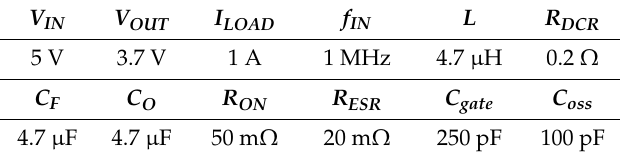
Table 3. Simulation conditions for multi-phase buck converter with ETM.